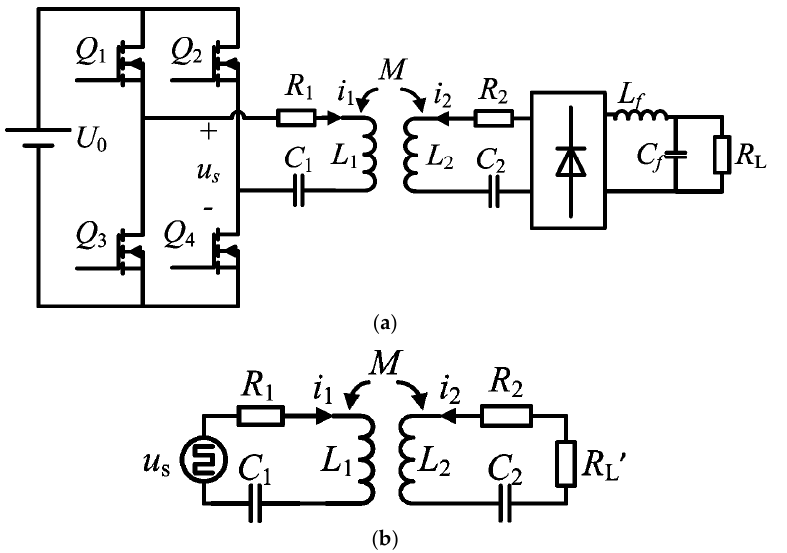
Figure 2. Power circuit and linear equivalent circuit of wireless power transfer (WPT) system: ( a ) power circuit; and ( b ) linear equivalent circuit.